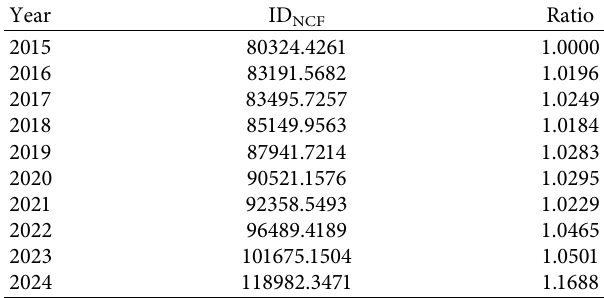
Table 2: Relative change ratios of NCF.